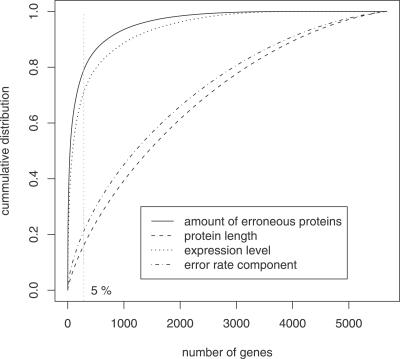
Relative Contribution of Each Gene to the Amount of Erroneous Proteins in Yeast if u = 5 × 10−4
The solid line shows the cumulative contribution of each gene tox̄. A steep increase, as seen here, indicates that few genes are responsible for most of the abnormal proteins in a cell. We also plot the cumulative distribution for the three components of
: protein length, ni (dashed line), number of functional proteins, yi (dotted line), and expected amount of erroneous proteins to synthesize one error-free protein,
(dash-dotted line). The curvature of the solid line is similar to the curvature of the dotted line. Hence, most of the abnormal proteins stem from few genes because these genes are also expressed at a very high level.